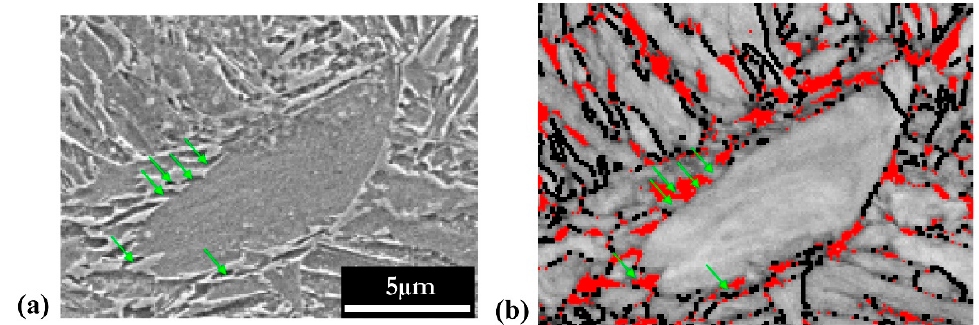
Figure 13. Zoom of Zone 1 in Figure 12. ( a ) SEM image ( b ) Band contrast and 10° grain boundaries (in black) together with retained austenite (in red) of the same zone than ( a ) obtained by EBSD. Yellow circles: martensite / austenite (MA) islands. Green arrows: bainite.